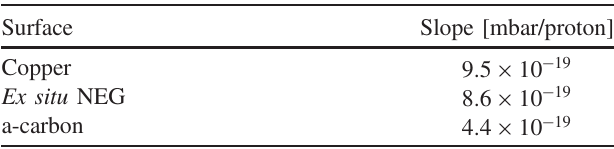
TABLE III. Slopes of the linear EC increase as a function of the bunch population and multipacting threshold values for the three surfaces.